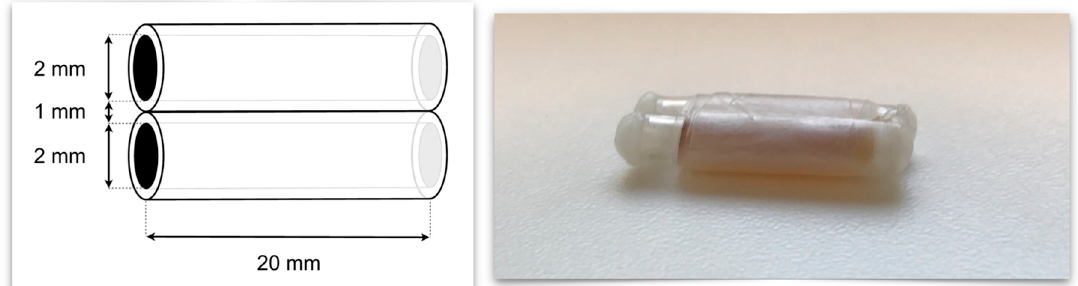
Figure 6. Left: Schematic drawing of a dual-tube phantom with 20 mm length and 2 mm inner diameter. Right: Photograph of a phantom with a 3 mm inner diameter filled with 10 mmol Fe/l tracer dispersion.